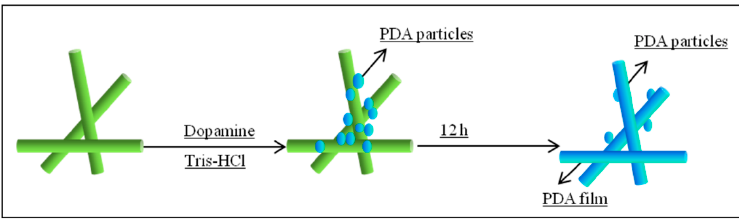
Figure 1. Schematic of the deposition process of PDA coating.